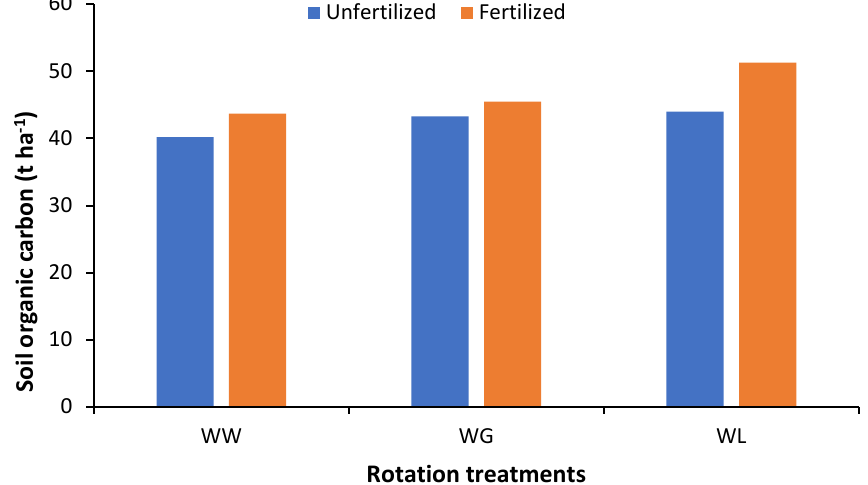
Figure 5. Effects of rotation treatments on SOC storage. WW—continuous wheat, WG—1 year of wheat followed by 1 year of grazing of natural grasses, WL—2 years of wheat followed by 2 years of legume and grass mixtures. Authors’ elaboration based on [151].